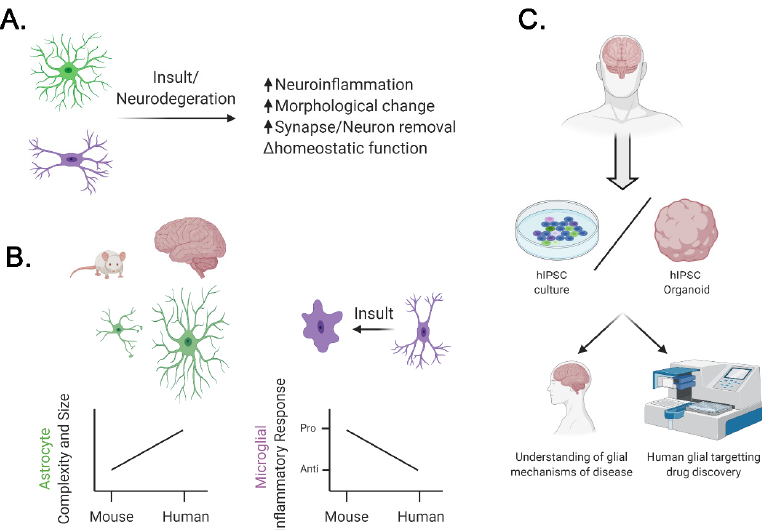
Figure 1. Bimodal role of glia in neurodegeneration and di ff erences between human and mouse glia. ( A ) Both astrocytes and microglia are poised to be critical players during neural insult due to their close association and interactions with neurons. Thus, during a neurodegeneration, there is an interplay between reduction in homeostatic functions and participation in neuroinflammatory response. Loss of regular homeostatic functions of glia, including reduced regulation of ion and neurotransmitter concentration in the extracellular space as well as reduced secretion of neurotrophic factors, can promote disease pathogenesis, while compensatory increase in these functions can delay disease onset. Neuroinflammation in glia alters their morphology and increases secretion of pro- and anti- inflammatory cytokines and participation in removal of damaged synapses and neurons. While initially this may be beneficial, chronic neuroinflammation seems to be harmful. ( B ) Humans and mice di ff er in the complexity of astrocyte processes, which is increased in humans relative to mice (left), and in microglial neuroinflammatory response to secreted molecules, which is decreased in humans (right). ( C ) Patient-derived human-induced pluripotent stem cells (iPSCs) can be used to study the cellular and molecular processes contributing to glial changes in neurodegenerative diseases as well as for high-throughput testing of potential drugs. Created with